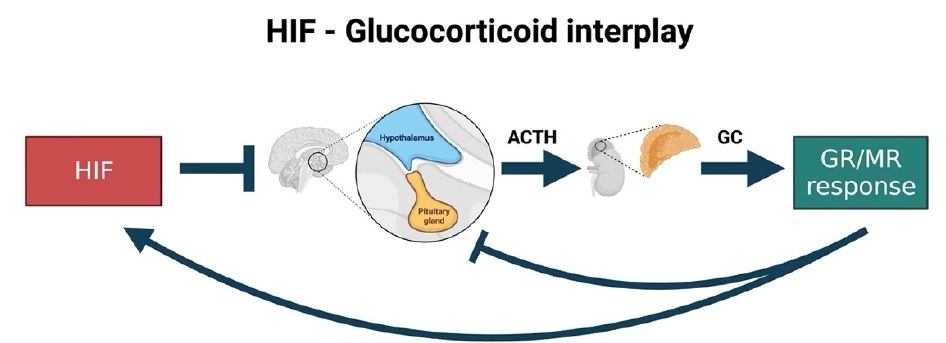
Figure 4. Speculative scheme of how putative HIF-GC crosstalk occurs in the zebrafish. Previous research highlighted that GCs may enhance both GR and MR-mediated responsiveness and stimulate the HIF signalling. Conversely, upregulated HIF levels may inhibit GC biosynthesis by negatively regulating pomca at the level of the pituitary gland. Consequently, this is believed to occur as a logic homeostatic response exerted by HIF signalling to control not only its own activity but that of glucocorticoids to facilitate inflammation resolution and homeostasis. Created with BioRender.com.